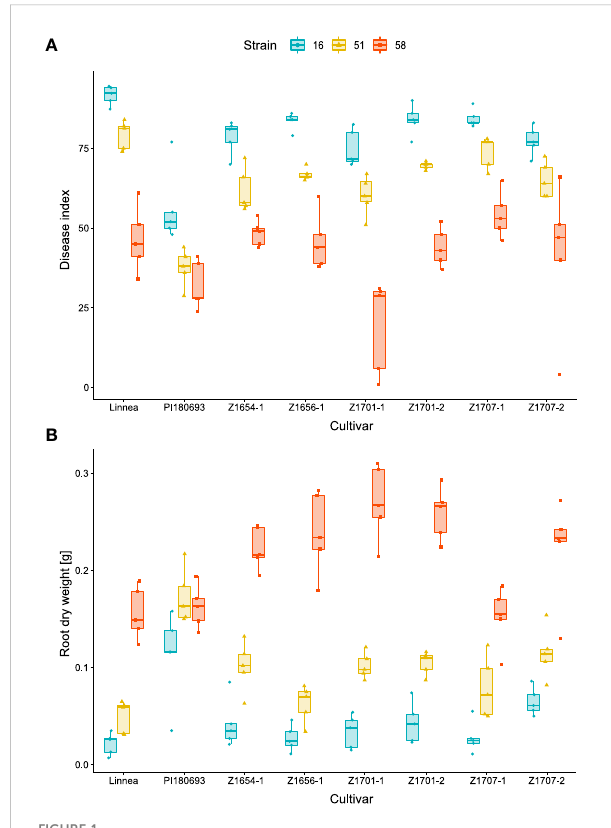
FIGURE 1 Virulence of Aphanomyces euteiches strains on pea cultivars. Disease indices (A) and root dry weight measurements (B) were assessed in growth chamber trials including six pea breeding lines and the two parental lines upon infection with A. euteiches strains UK16 (high virulence), SE51 (intermediate virulence) and SE58 (low virulence). Disease index scores (0 = completely healthy plant, 100 = completely diseased) and root dry weight measurements [g] are averages of fi ve biological replicates.